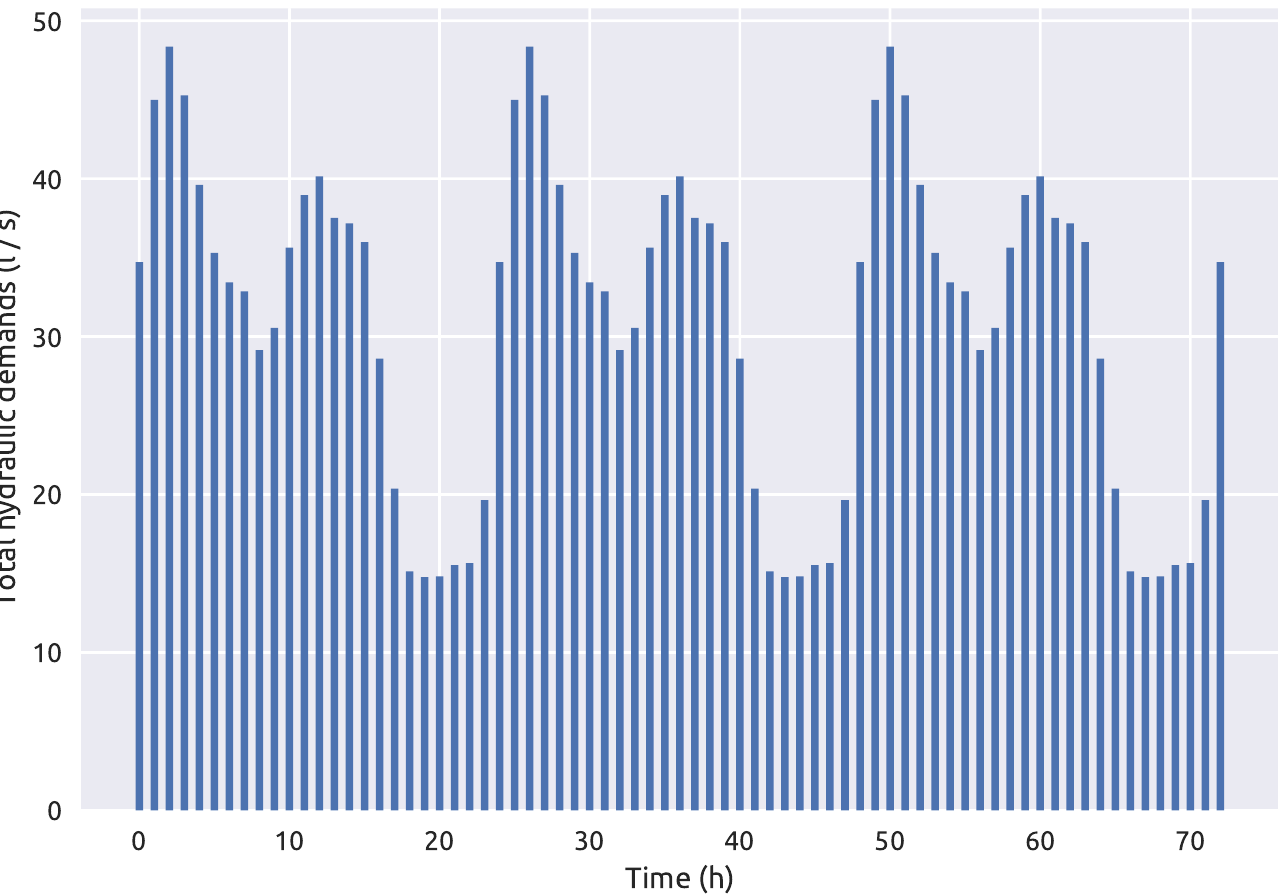
Figure 3. Richmond water distribution network total hydraulic demands over a 72 h period.